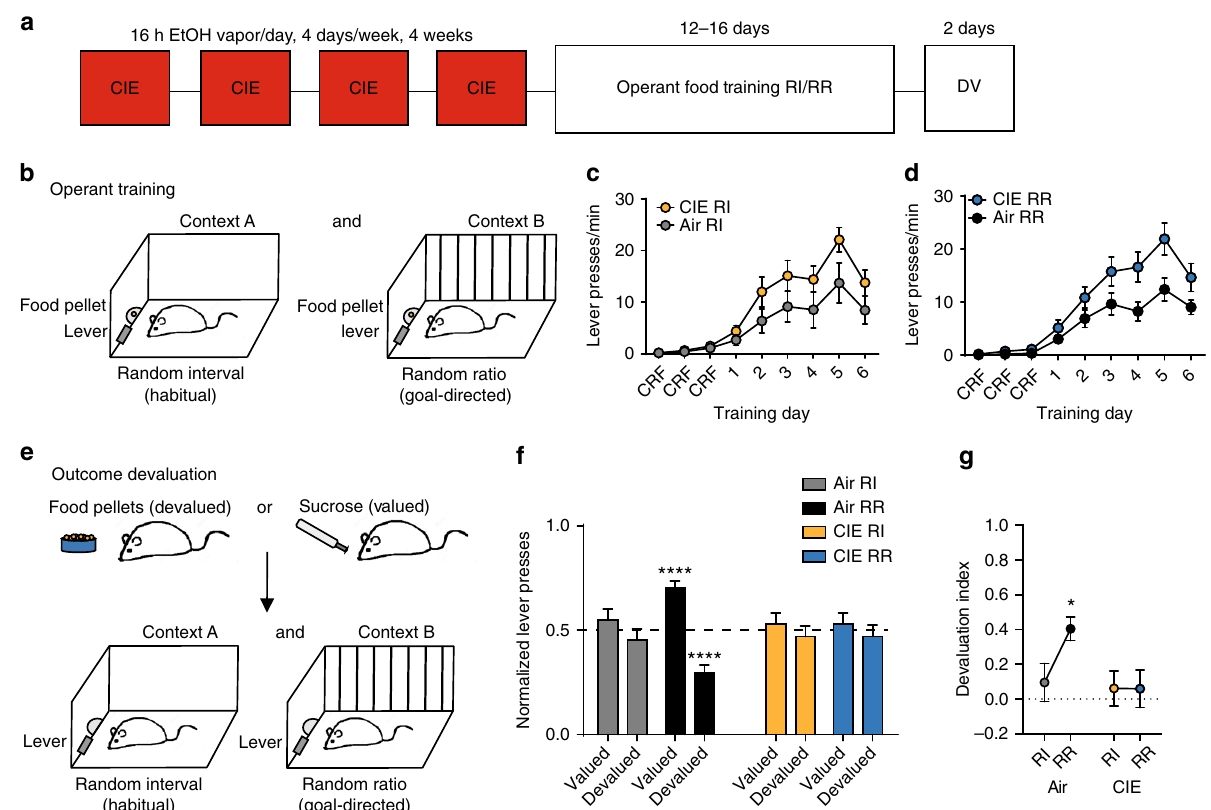
Fig. 1 Chronic ethanol exposure and repeated withdrawal biases towards habitual control over actions. a Experimental timeline of CIE and the following operant training and subsequent outcome devaluation testing (DV). b Mice (3 cohorts, Air n = 15, CIE n = 19) are trained to press the same lever (left or right) for the same food outcome (food pellet or sucrose) in two distinct contexts under RI or RR schedules of reinforcement. c , d Response rate of lever pressing during acquisition under RI ( c ) or RR ( d ) schedules. e Schematic of the outcome devaluation procedures. On the devalued day, mice receive 1 h free access to the outcome previously produced by lever pressing, immediately followed by a 5 min extinction test in each context. To control for effects of general satiety on responding, on the valued day mice receive 1 h free access to the remaining outcome, immediately followed by a 5 min extinction test in each context. f Normalized lever presses showing the distribution of lever pressing between the valued and devalued day in each training context. g Devaluation index (see Methods) for each group in the previously trained RI and RR contexts. Data are represented as mean ± SEM. **** p < 0.001, * p < 0.05 re fl ect one-sample t tests against 0.5 and 0,